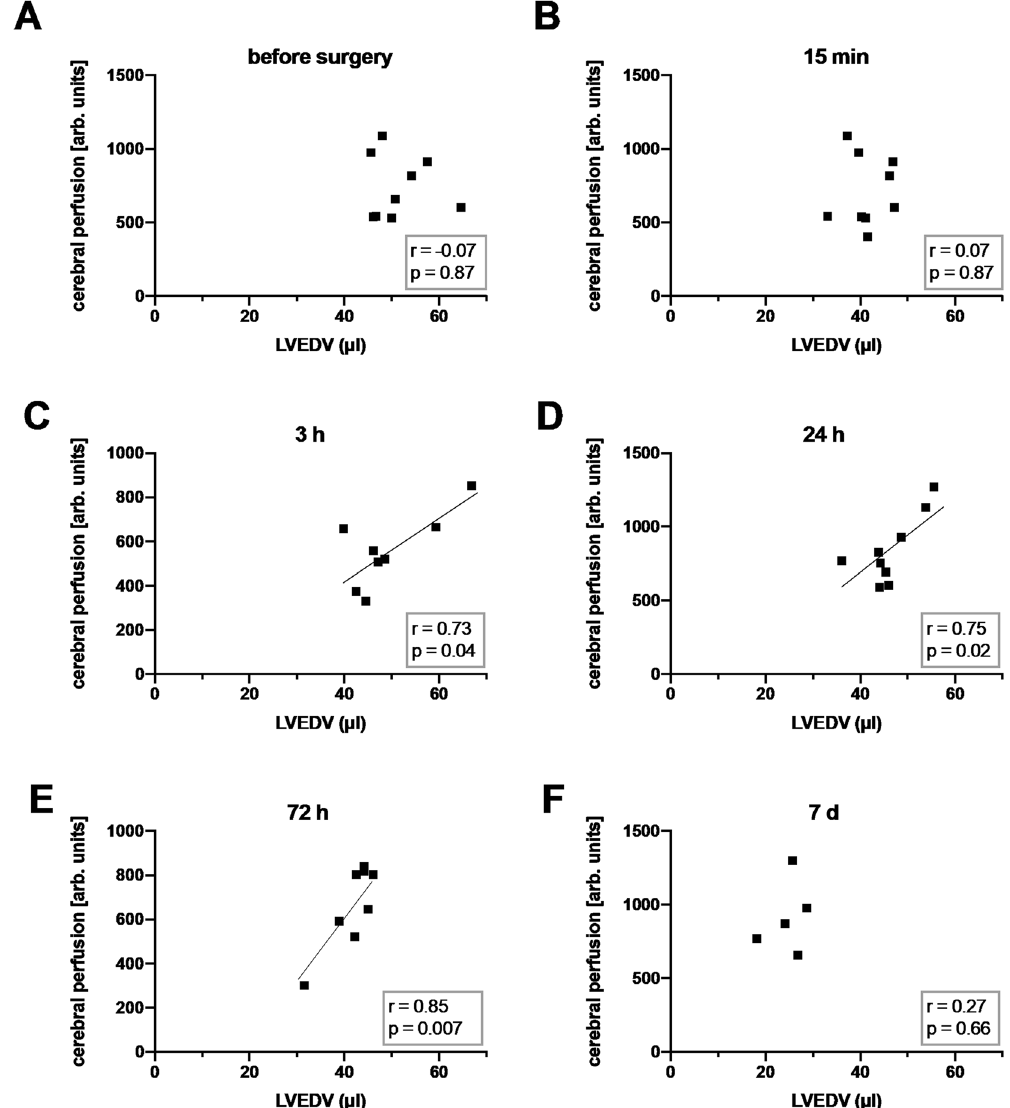
Figure 4. Correlations of LVEDV with cerebral perfusion after SAH. ( A )–( F ) Correlations of left ventricular end-diastolic volume (LVEDV) with cerebral perfusion at the indicated times post-surgery. Extended analyses can be found in the supplementary material. n = 9 for the time points before surgery and 15 min, 3 h, 24 h postop.; n = 8 at 72 h postop.; n = 5 at 7 days postop. Correlation is expressed by Pearson’s or Spearman’s correlation coefficient (r) as appropriate, with p < 0.05 considered statistically